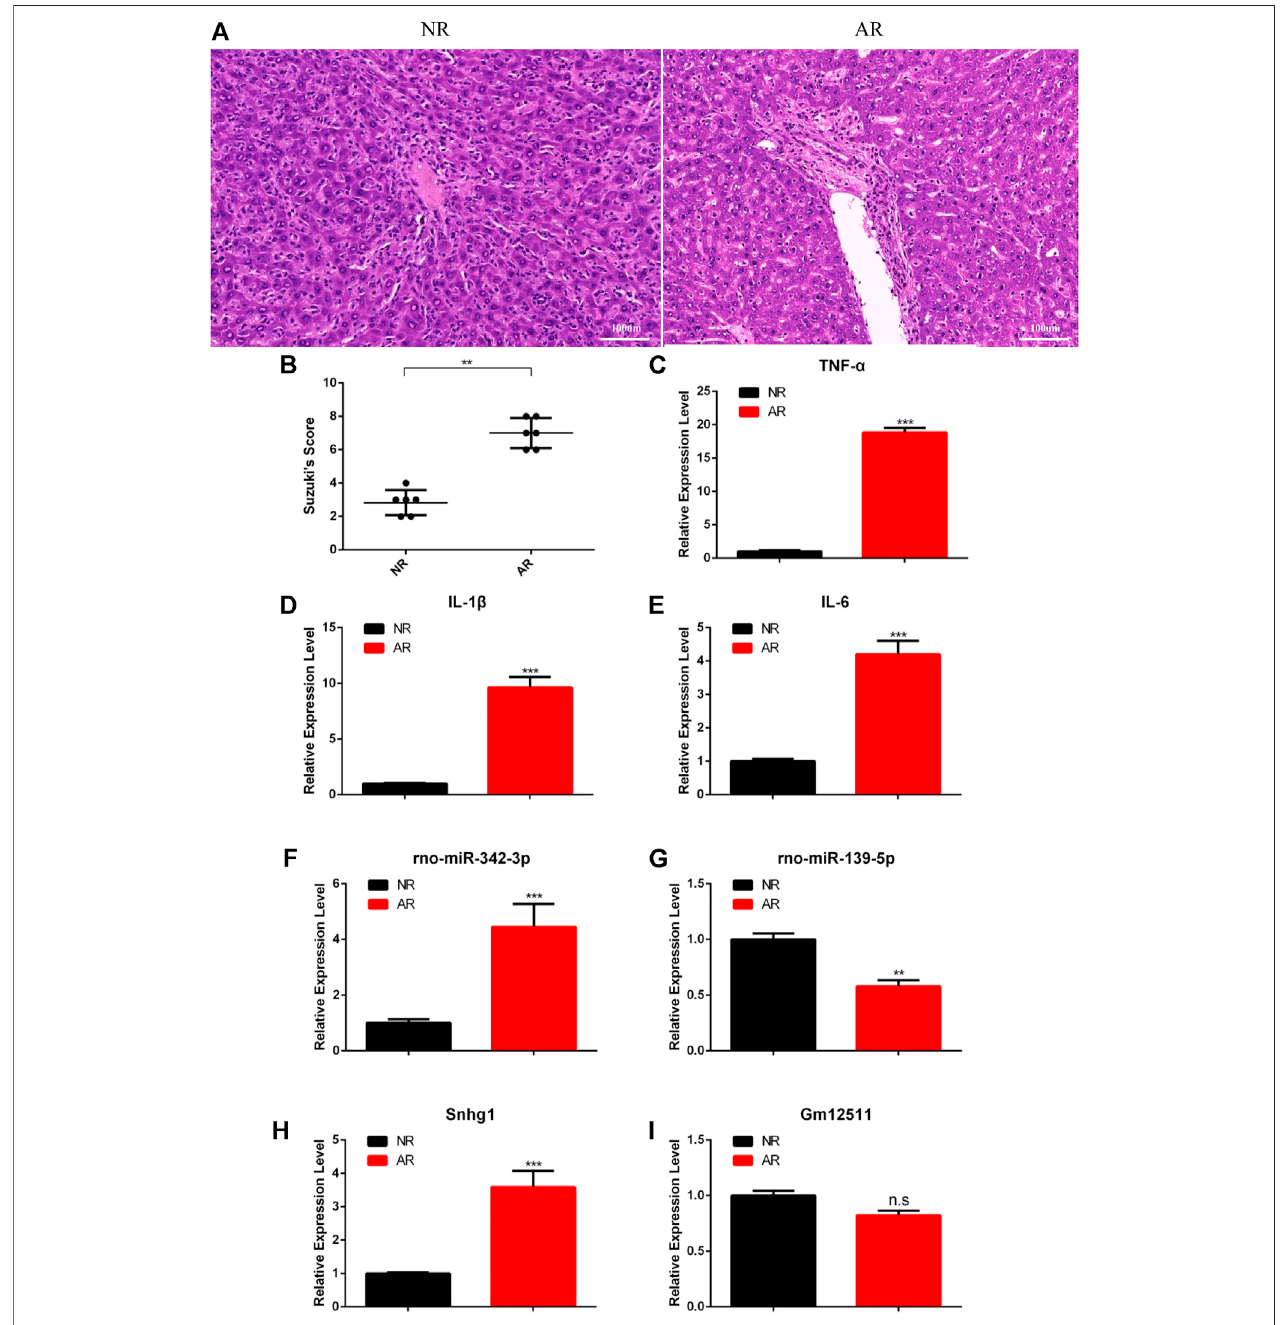
FIGURE 6 | Experimental veri fi cation for the ceRNA network. (A) HE staining for graft samples after liver transplantation in rats. (B) Suzuki ’ s histological score for tissuedamage. (C – E) Real-time fl uorescencequantitativePCRdetectionforrelatedin fl ammatoryfactors. (F – I) Real-time fl uorescencequantitativePCRdetectionforthe ceRNA network. All the experiments were performed at least three times, and the data were presented as means ± SD. (* p < 0.05; ** p < 0.01; *** p < 0.001; ns, not signi fi cant).